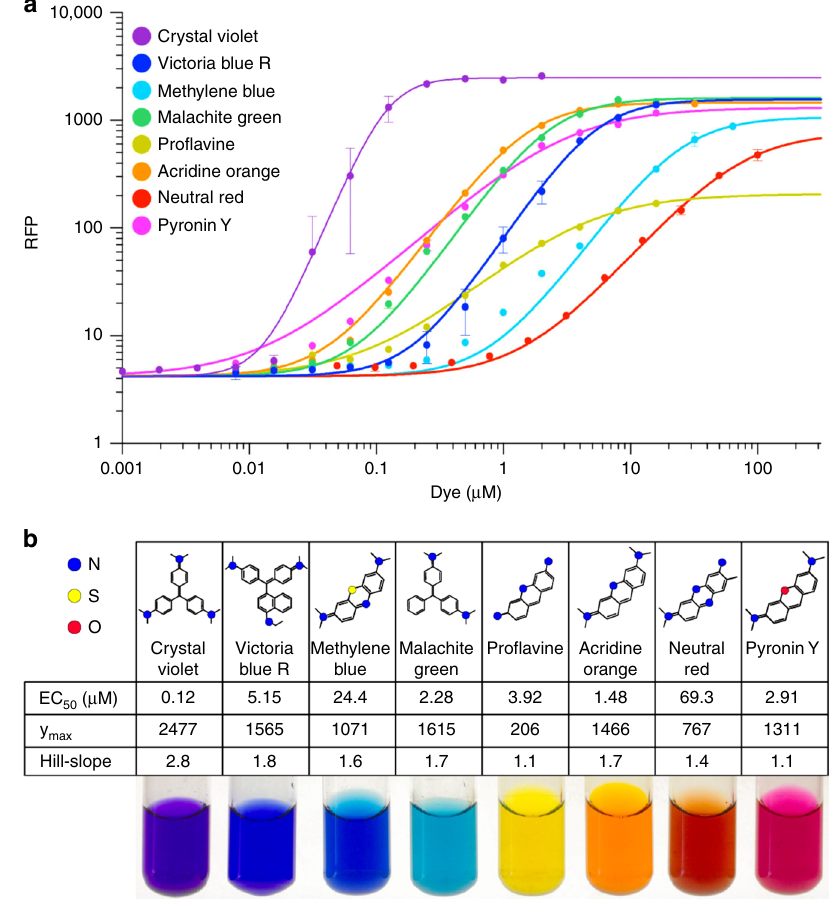
Fig. 2 Cationic dyes induce EilR-regulated promoters. a Response of P JExD to the inducing dyes as measured by single-cell RFP fl uorescence of E. coli containing the low-copy plasmid pTR_sJExD-rfp. b Values for EC 50 , amplitudes (y max ), and Hill-coef fi cients are used to characterize the response of P JExD to cationic dyes. Colored circles in the chemical structures indicate N (blue), S (yellow), and O (red). Photographs show the corresponding inducing dyes in concentrated aqueous solutions. Values and error bars in a represent the means and standard deviation of biological triplicate measurements. Response curves (R 2 > 0.99) and numerical values in b were obtained by non-linear regression analysis in a 4-parameter variable slope model using average values of fl uorescence measurements from three independently grown